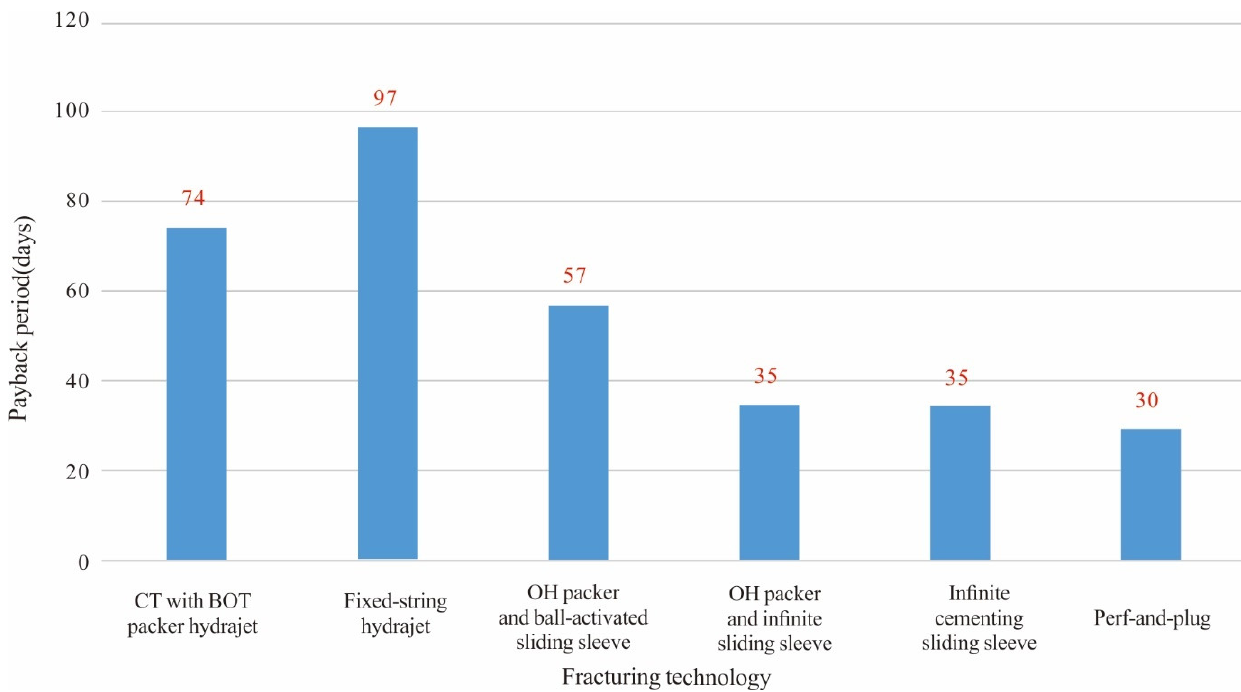
Figure 9. Payback periods for horizontal well multistage fracturing technologies.